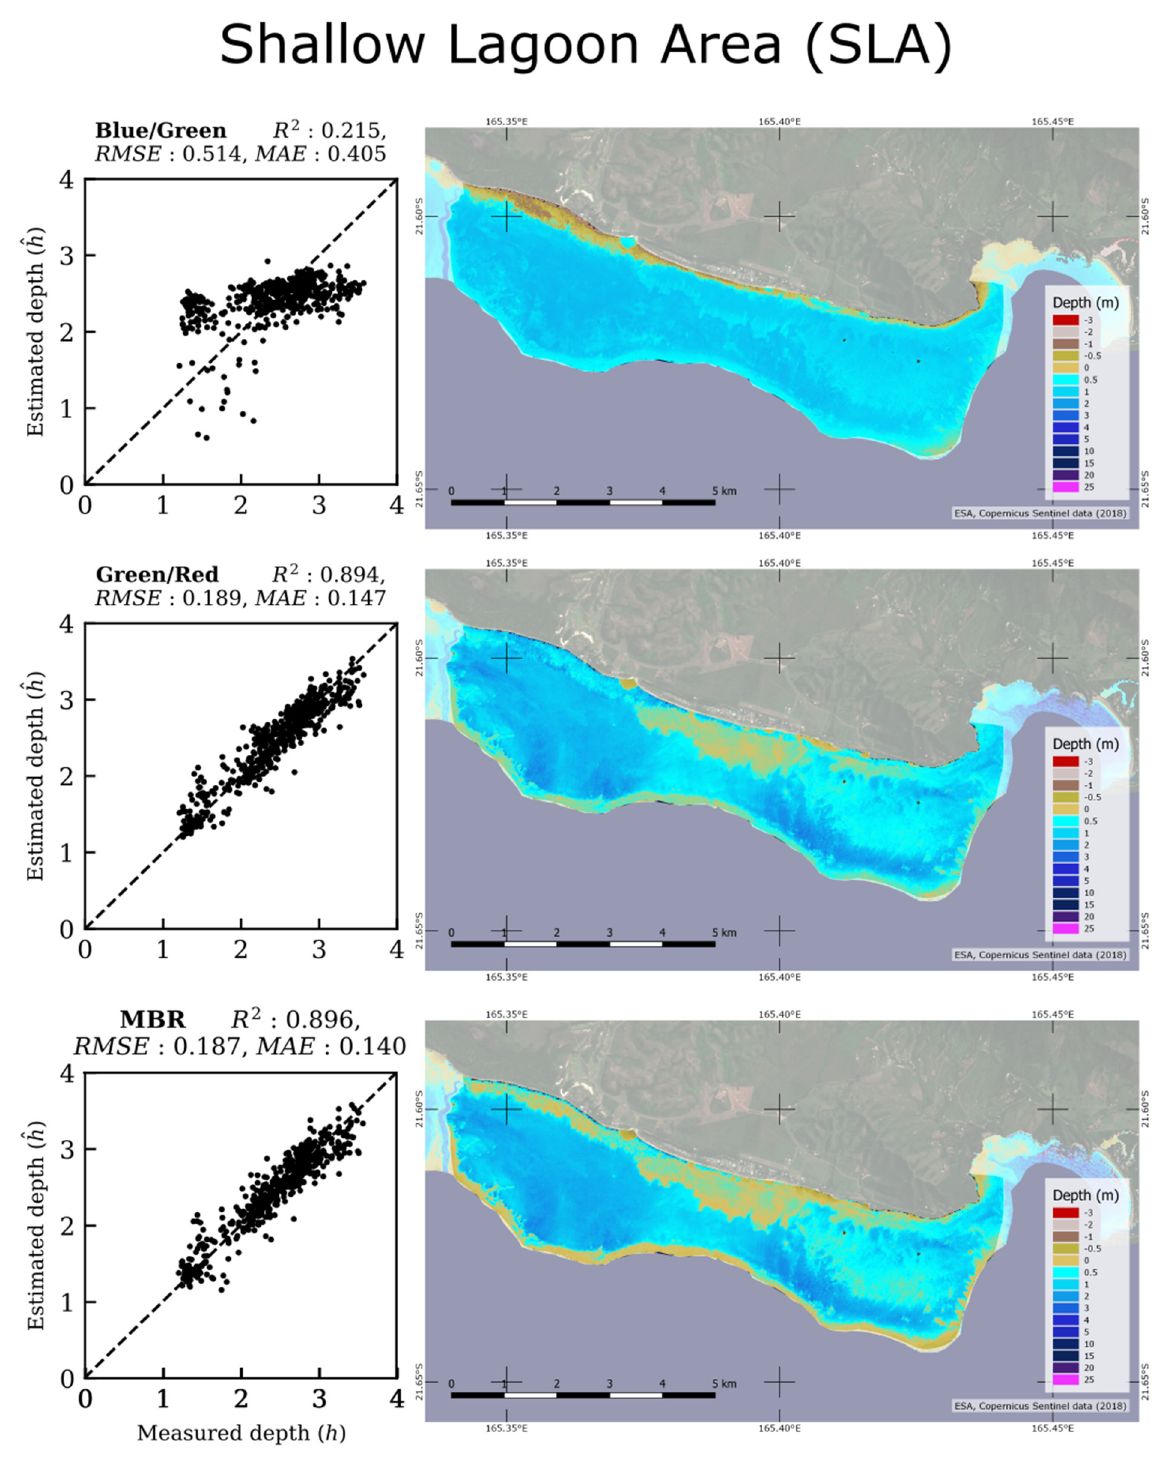
Figure 4. Applications to the SLA of the blue/green SBR model ( top ), the green-red SBR model ( middle ) and the MBR model ( bottom ). Accuracy metrics are provided above each validation plot on the left-inside.